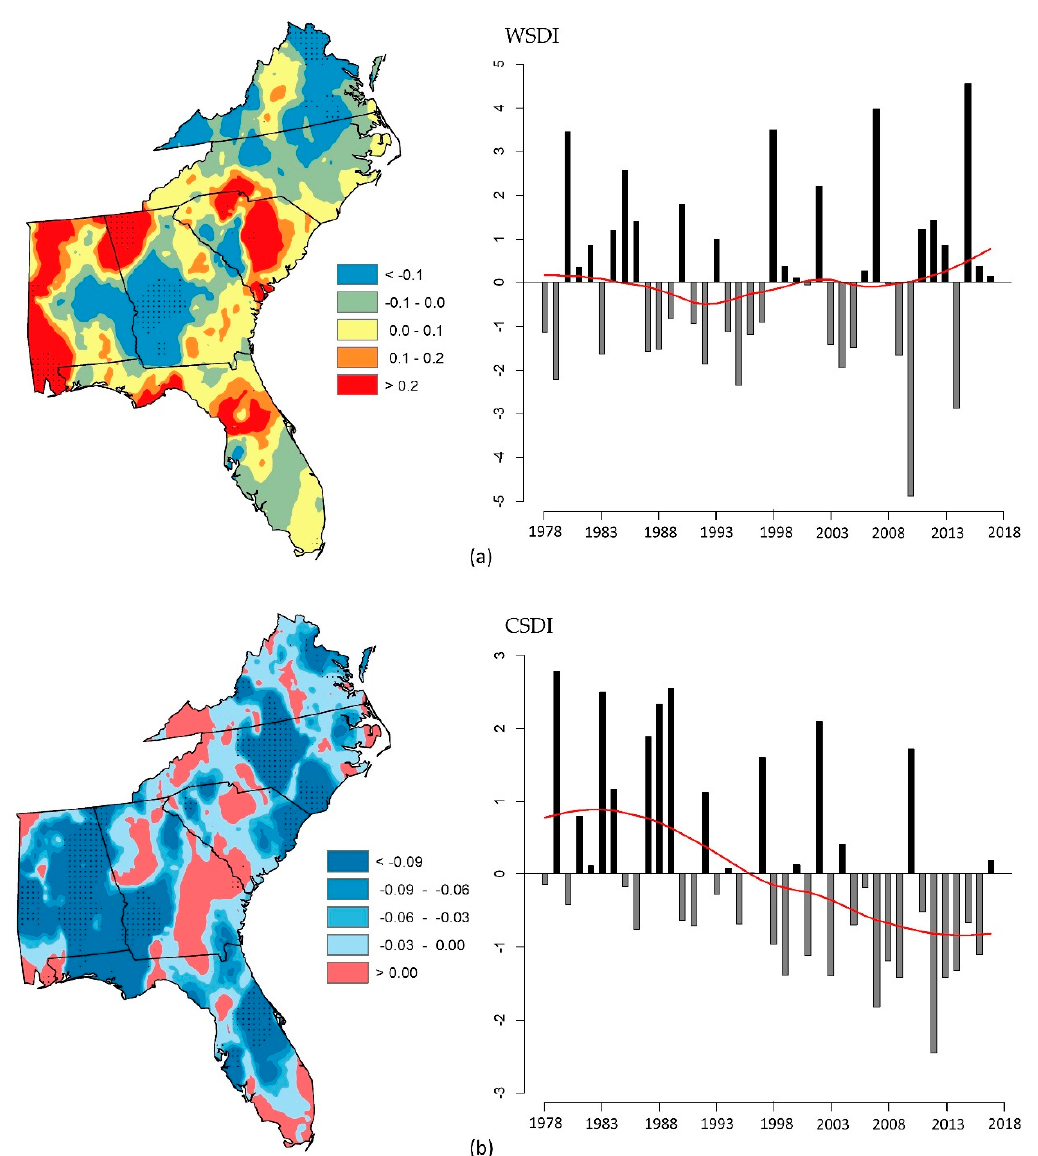
Figure 8. Same as Figure 5, but for duration indices: ( a ) warm spell duration index (WSDI); ( b ) cold spell duration index (CSDI). Maps units: days per decade; plot units: days.